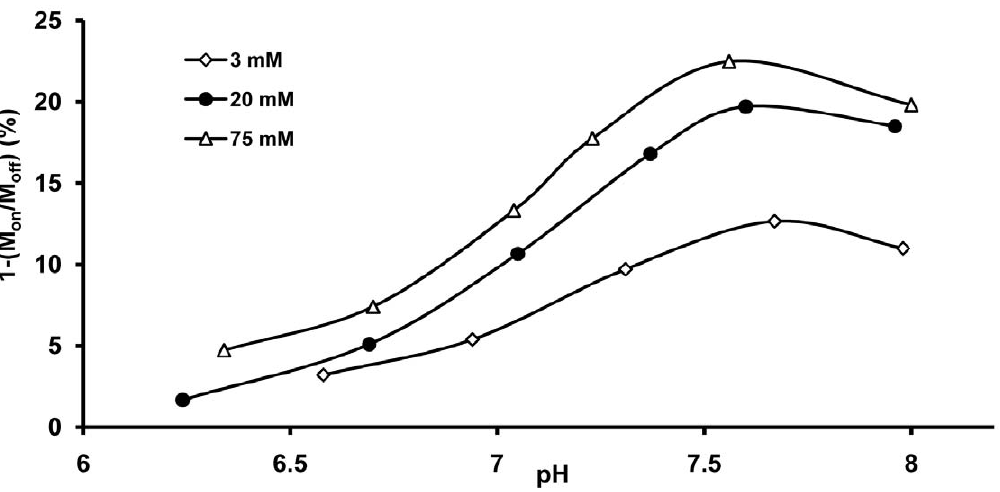
Figure 8. Amide proton CEST intensity versus pH for three different concentrations of TmDOTA-(gly) 4 2 . No lipid was present in this experiment. The amide proton CEST intensity was measured at 9.4 T and 310 K using a B 1 =7.0 m T and a presaturation time of 6 s.